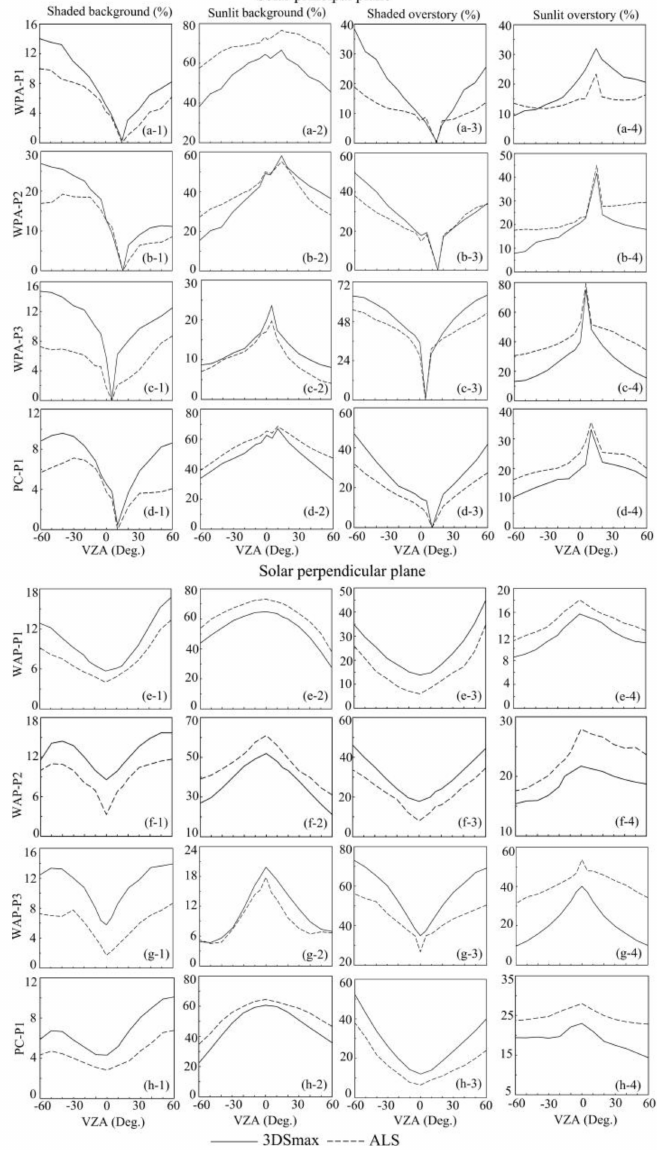
Figure 8. Comparisons between the four forest component results obtained from ALS- and 3DSMax-based results in both solar principal and perpendicular planes for forest plot WPA-P1 (insets a,e ), WPA-P2 (insets b,f ), WPA-P3 (insets c,g ) and PC-P1 (insets d,h ). The solar zenith and azimuth angles were 15 ◦ and 180 ◦ , 15 ◦ and 160 ◦ , 5 ◦ and 100 ◦ , 10 ◦ and 45 ◦ for forest plots WPA-P1, WPA-P2, WPA-P3, and PC-P1, respectively. Negative view angles correspond to the forward-scattering directions and the positive angles to the backscattering